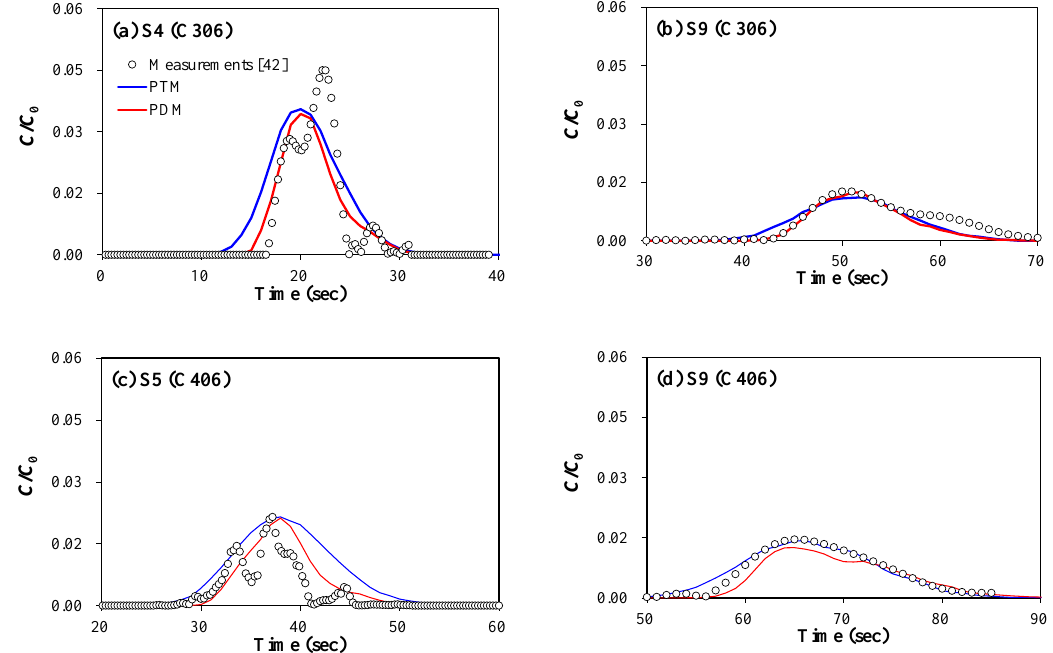
/ W = 0.45 within the channel